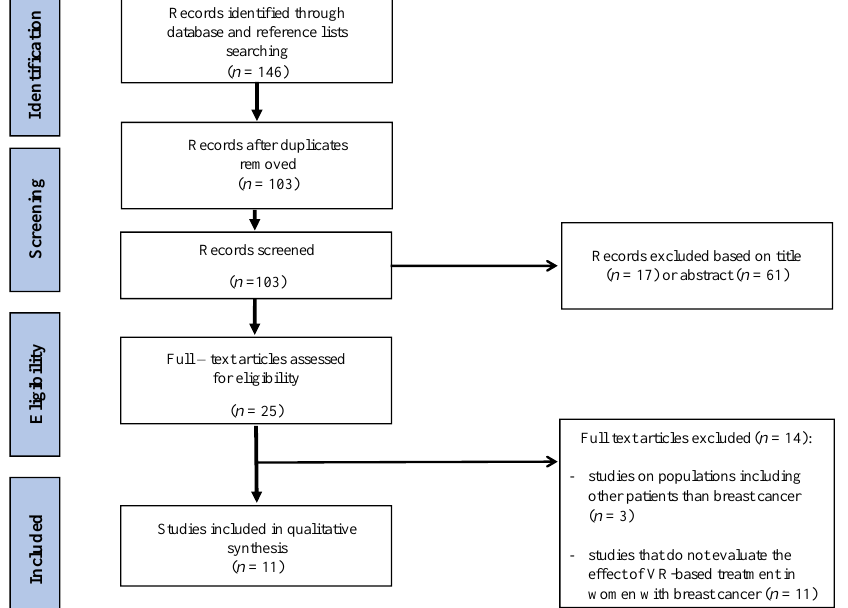
Figure 1. PRISMA flowchart of the search strategy process.